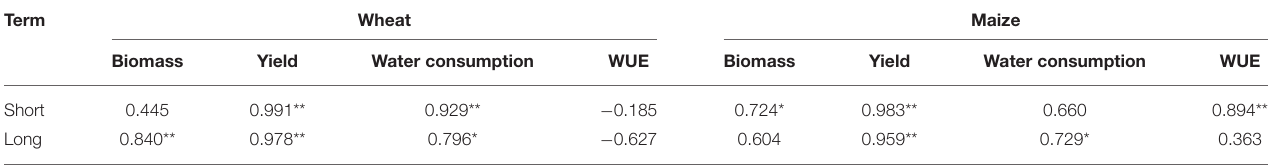
Frontiers in Agronomy |